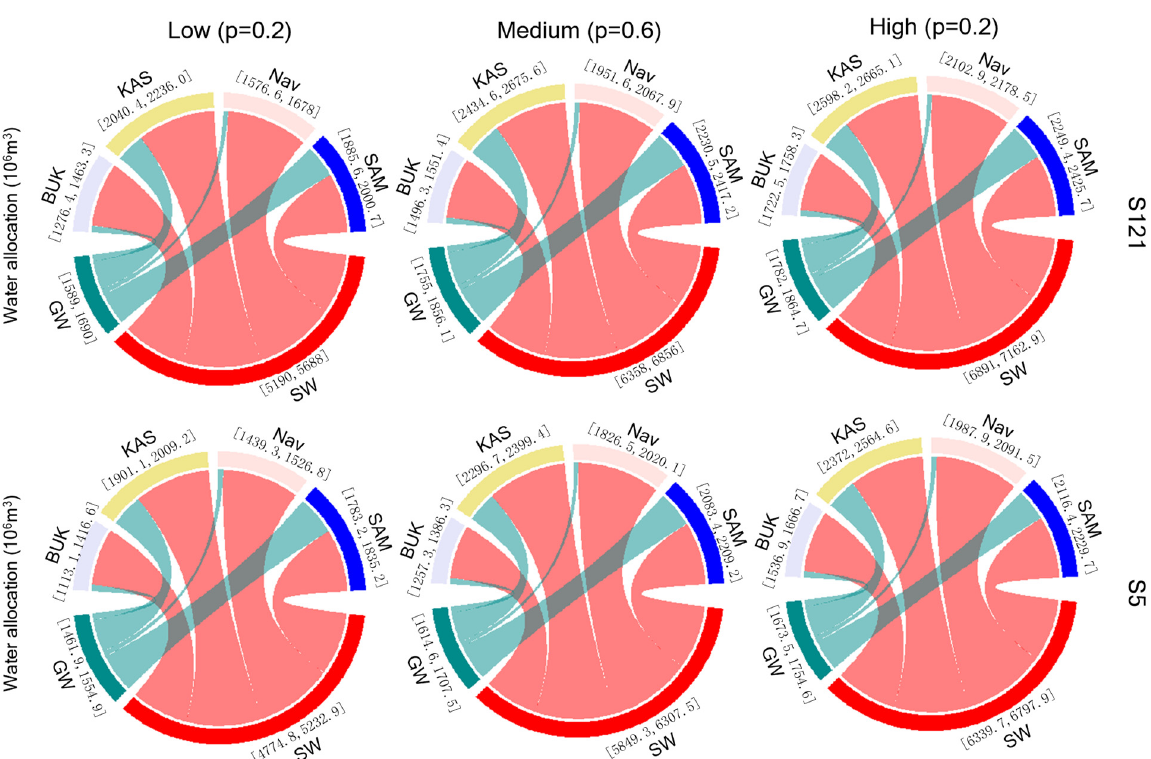
Figure 4. The patterns of water-allocation targets in different